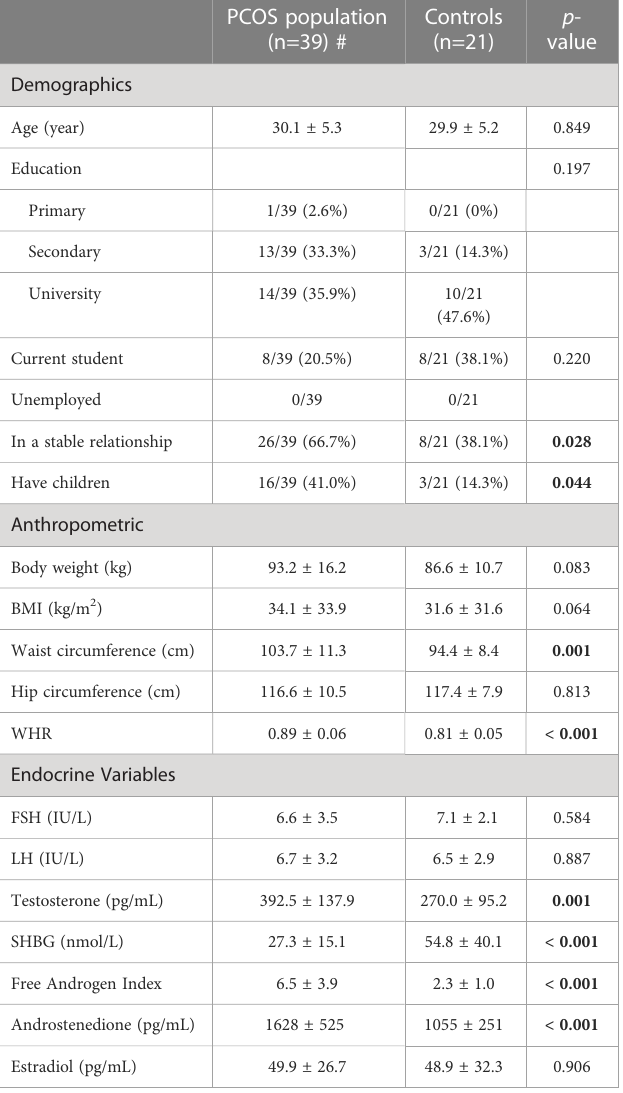
TABLE 1 Baseline characteristics of the PCOS population as well as the control